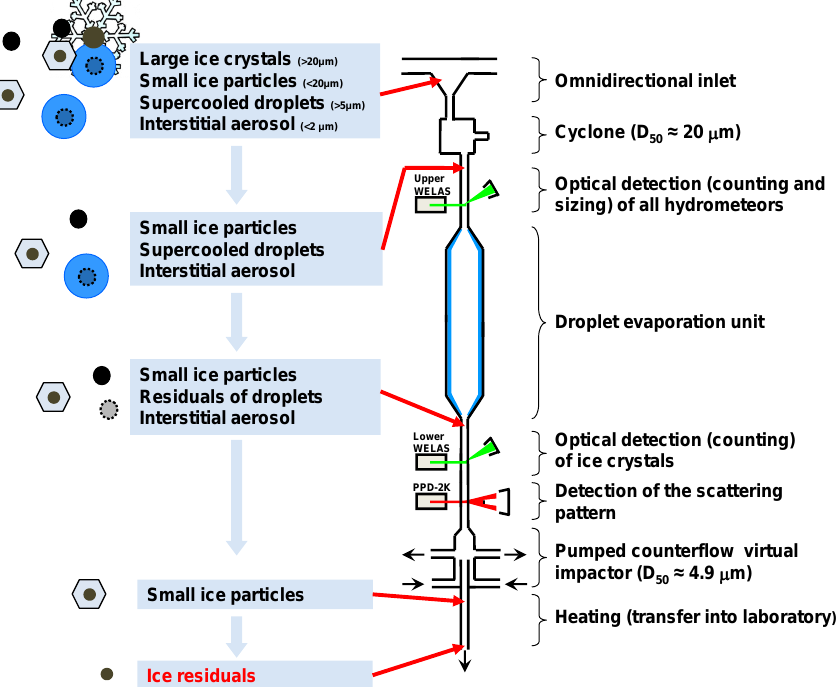
Figure 1. Sketch of the Ice Selective Inlet. The particulate matter contained within the sample flow is visualized on the left-hand side of the